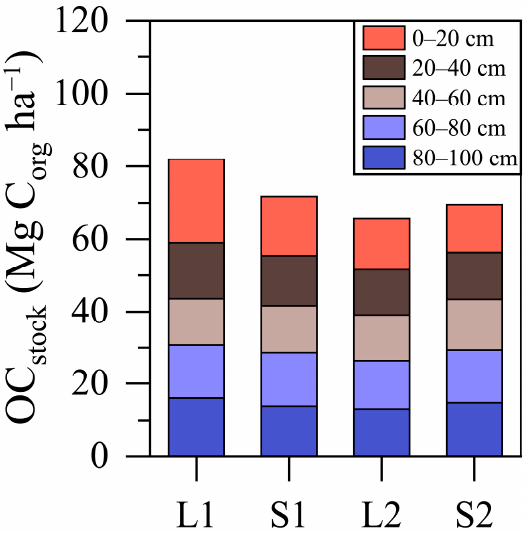
Figure 6. Variation in organic carbon stocks of each segment across distinct sampling stations along the whole 0–100 cm profile .